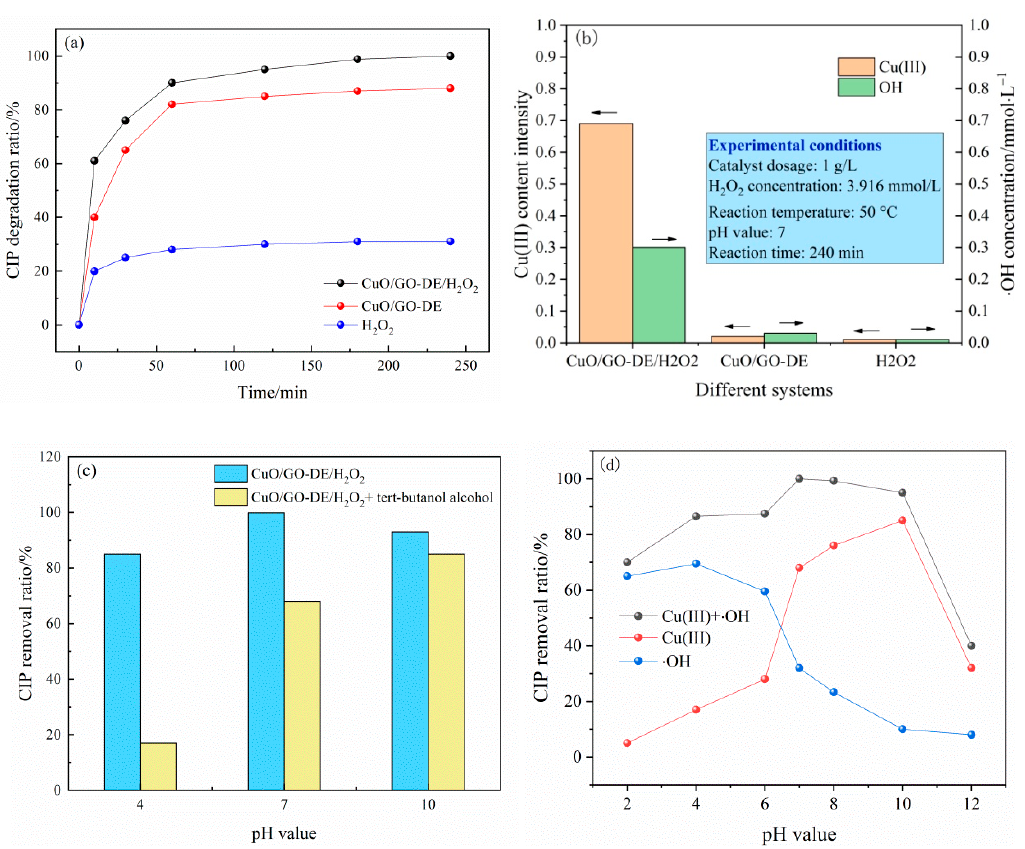
Figure 5. ( a ) Removal of CIP by different systems; ( b ) ·OH concentration and Cu(III) measurement in different systems; ( c ) ·OH scavenging experiments; ( d ) contribution of ·OH and Cu(III) on CIP removal ratios in different pH value.